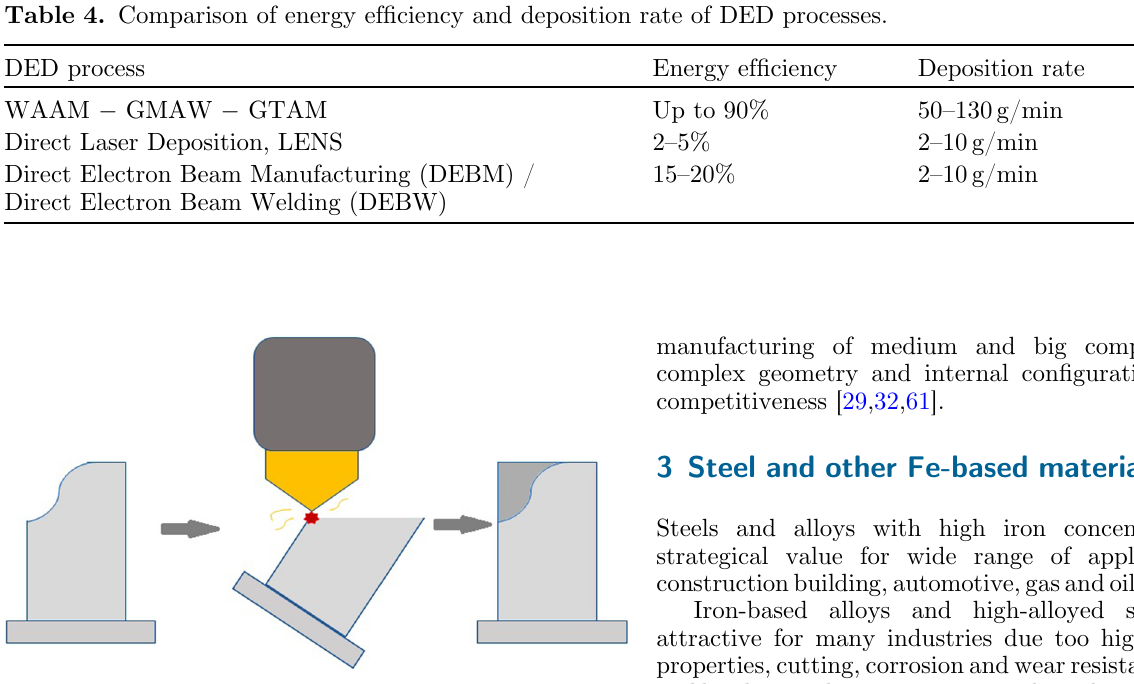
Fig. 4. Schematic view of repairing of turbine blade using DED